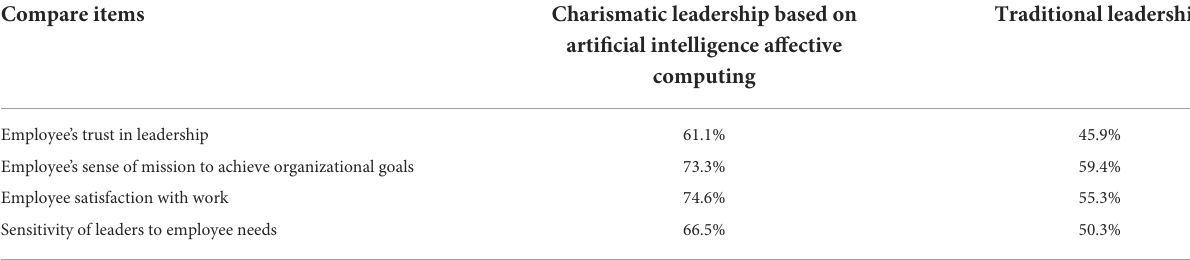
TABLE 5 The average data comparison table of the psychological state prediction analysis of the two leaders’ attitude toward employees’